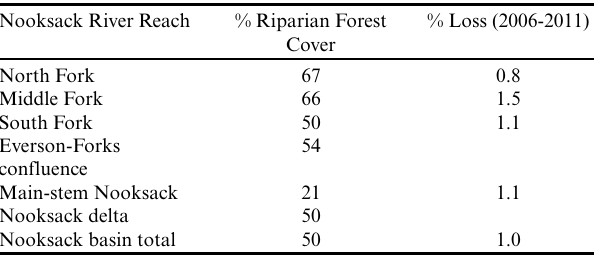
Table 4 . Forest cover in the Nooksack River historical channel migration zone. Values are ratios of riparian forest area to total riparian area, expressed as percentages. Riparian forest cover values were determined from 2013 LIDAR (light detection and ranging) data (Northwest Indian Fisheries Commission